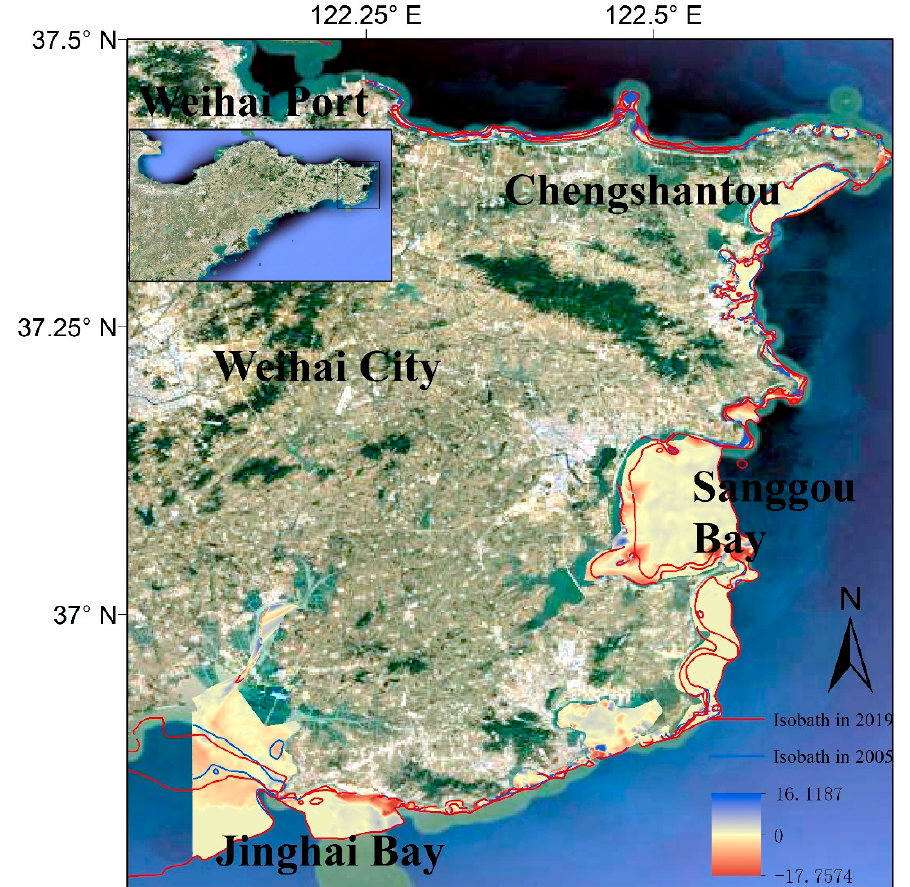
Figure 11. Isobaths and scouring–siltation changes between Chengshantou and Jinghai Bay. Figures 12 and 13 show the elevation change of the cross-section.